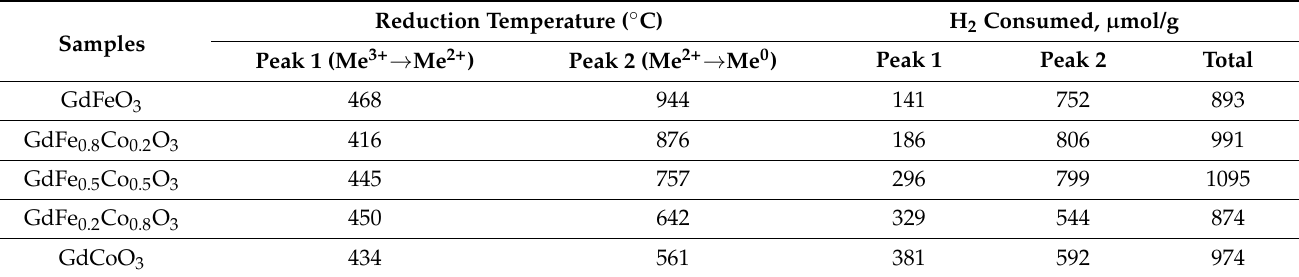
Figure 3. ( a ) H 2 -TPR profiles for each sample; ( b ) XRD patterns of GdFe 1 − x Co x O 3 after reduction at 900 °C. Table 3. H 2 -TPR profiles analysis